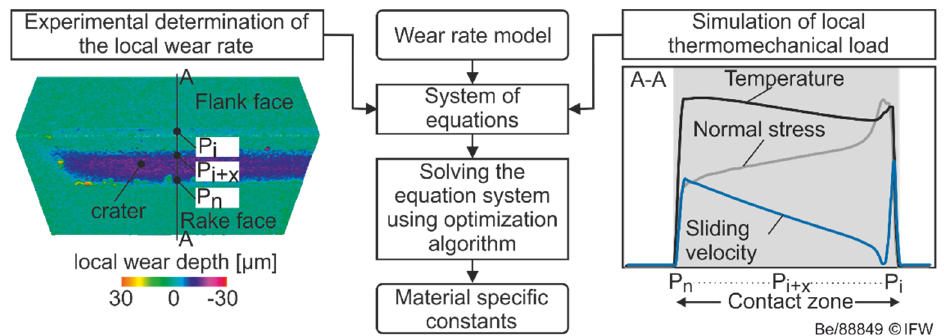
Figure 5. Parameterization of the wear rate model.